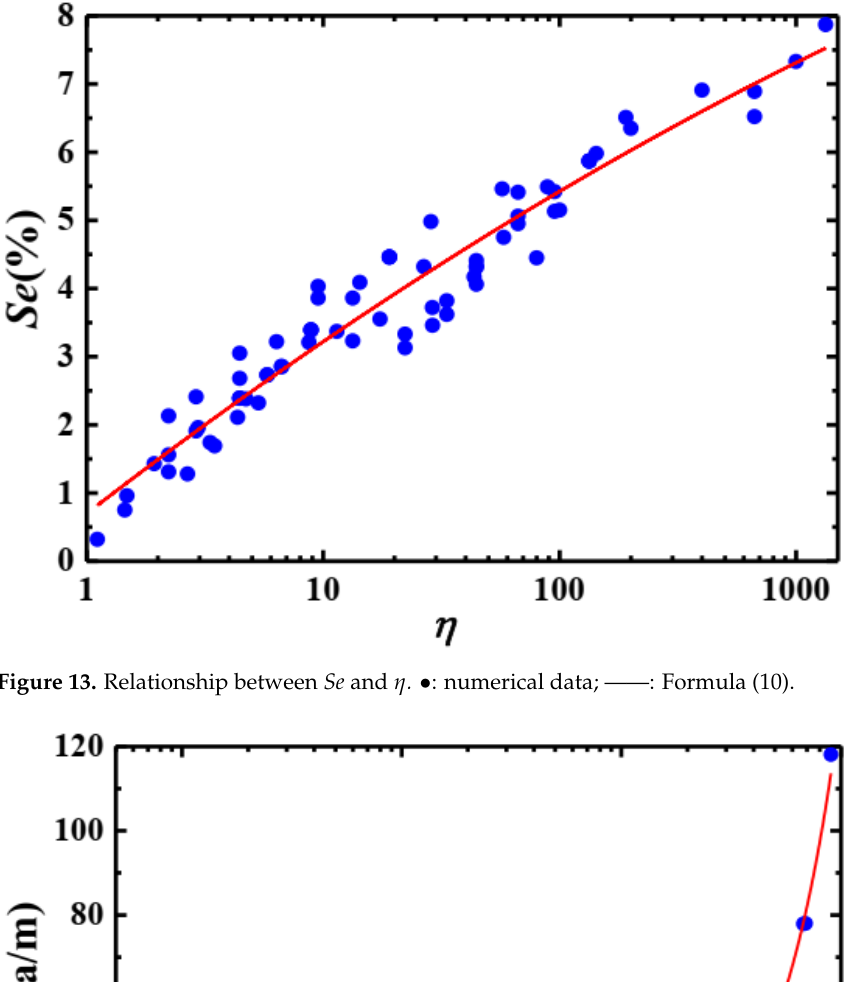
Figure 13. Relationship between Se and η . • : numerical data; ——: Formula (10).